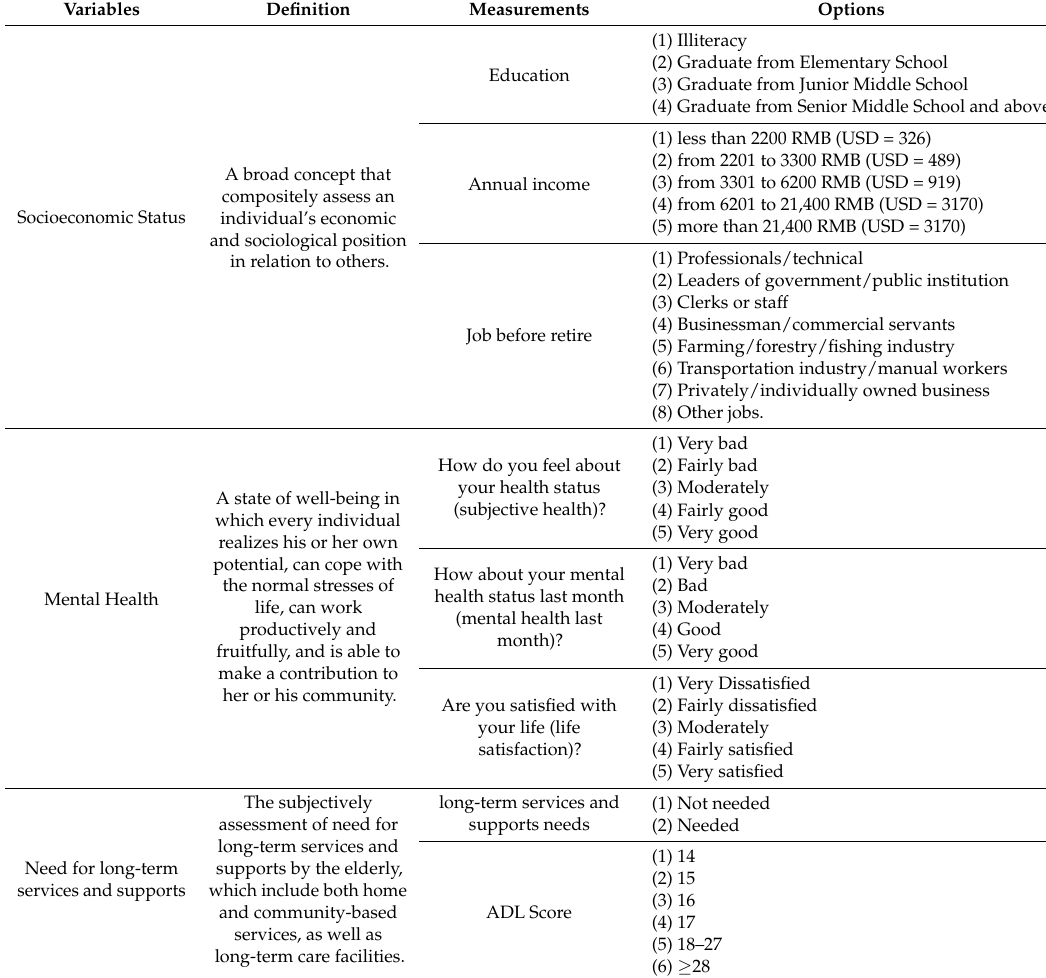
Table 1. Measurements of the variables in this